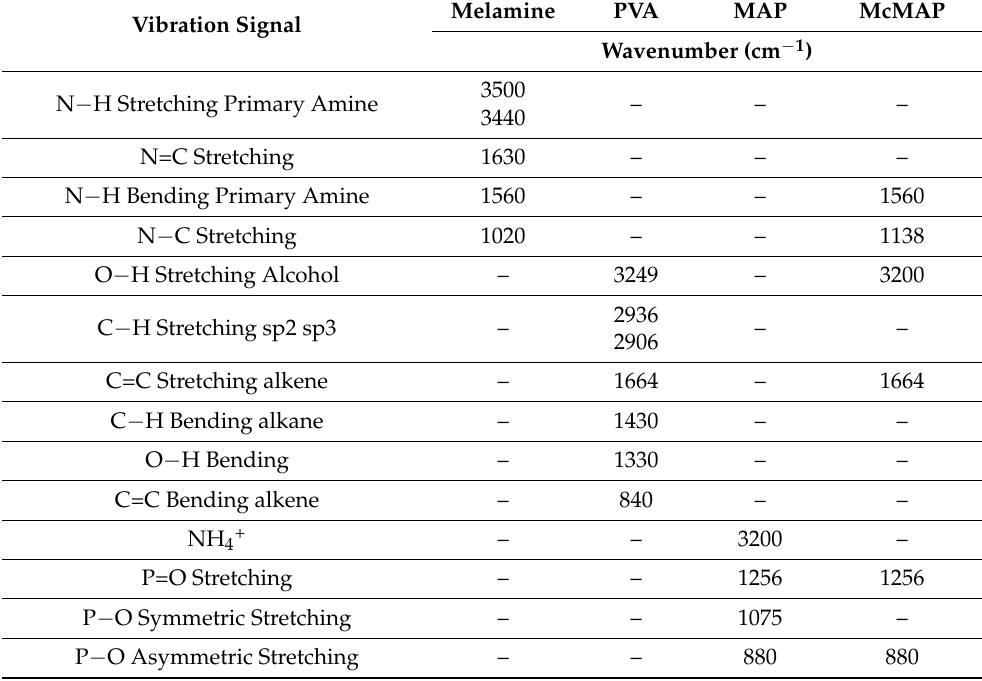
Table 2. Infrared vibration signals from reagents and microcapsules.